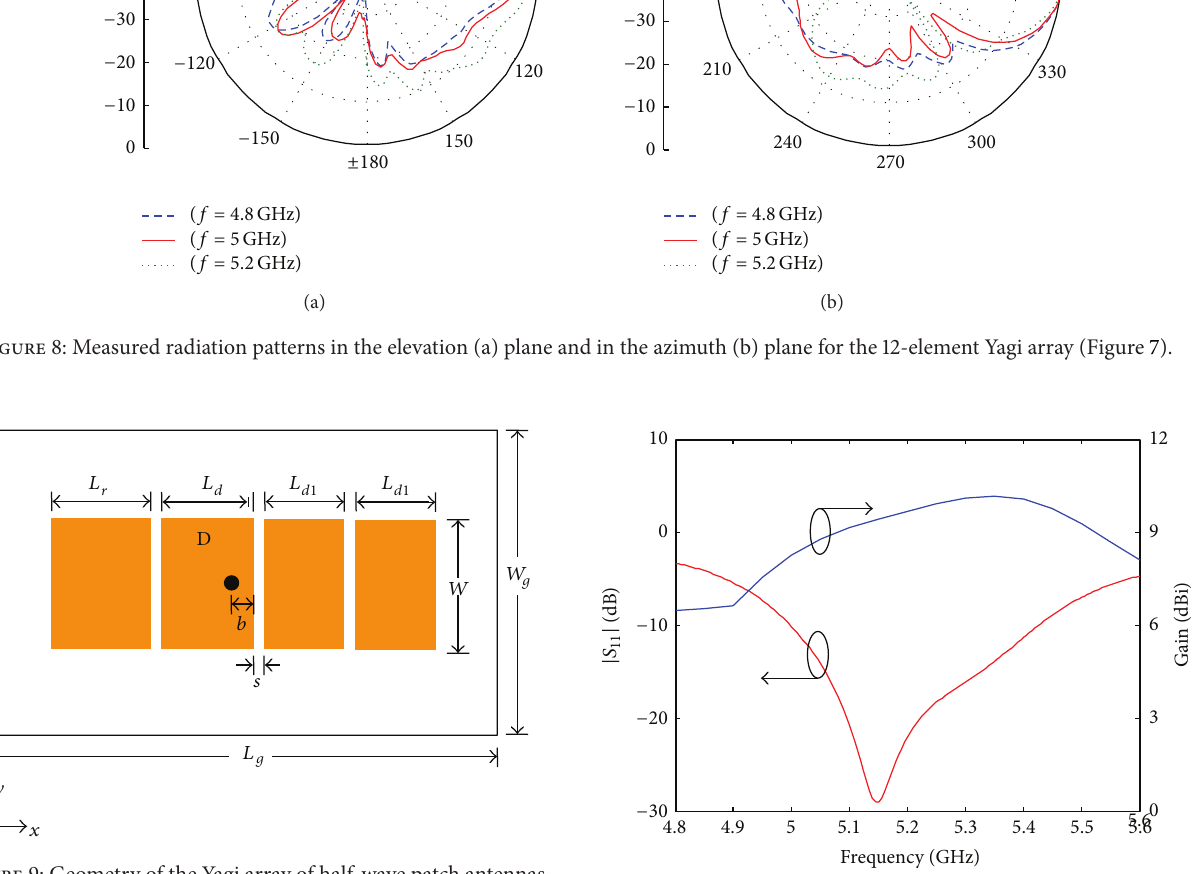
Figure 10: Reflection coefficient and gain for the 4-element Yagi array of half-wave patch